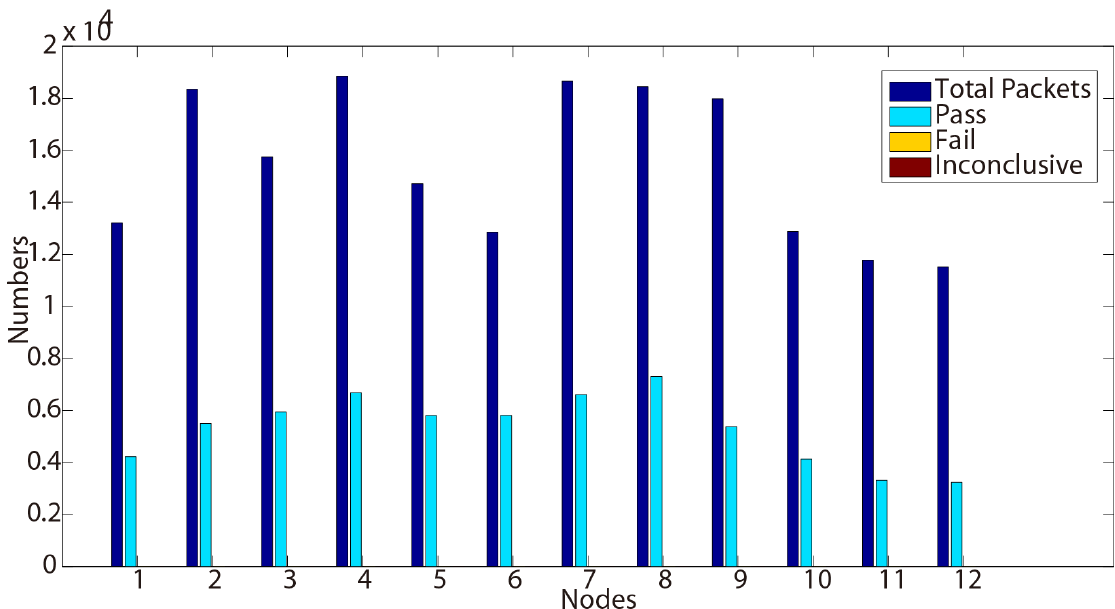
Figure 7. Test results for Property 4 (Day